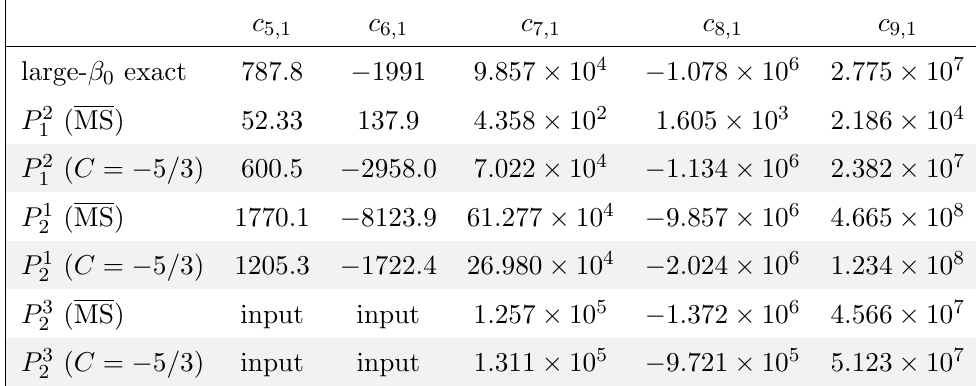
( u ), P 1 ( u ) and P 3 ( u ) 1 2 2